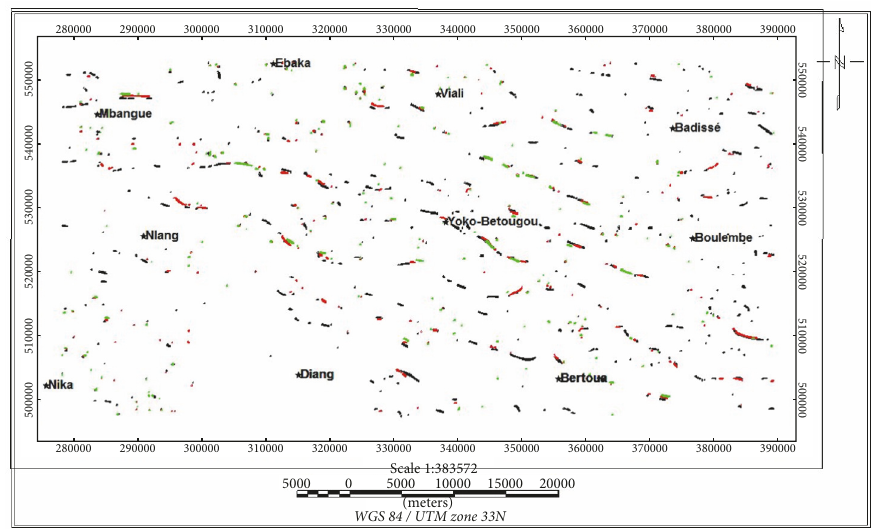
Figure 5: Superposition of maxima of horizontal gradient of RTE upward continued to 1 km, 2km, and 3 km.